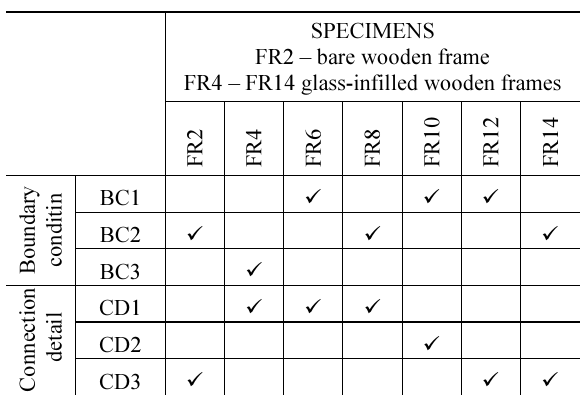
Table 1. Boundary conditions and connection details assign-